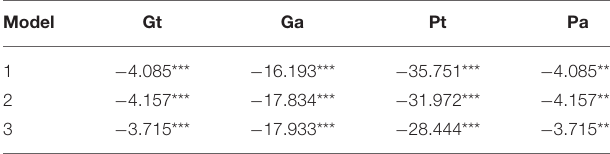
TABLE 4 | Westerlund’s (87) ECM-based approach. Model